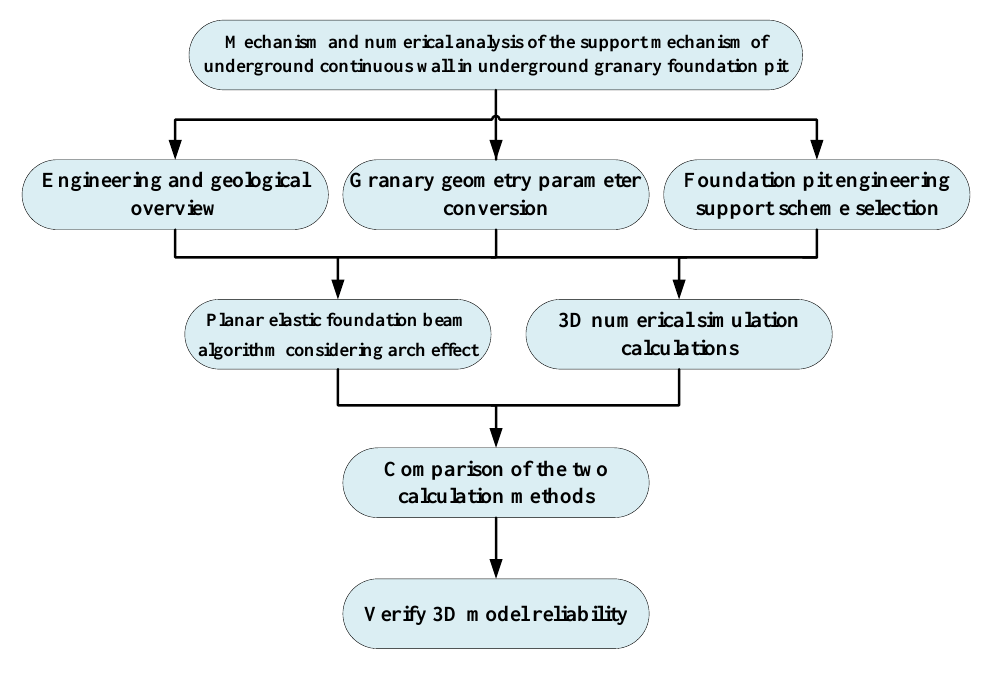
Figure 1. Technology roadmap.